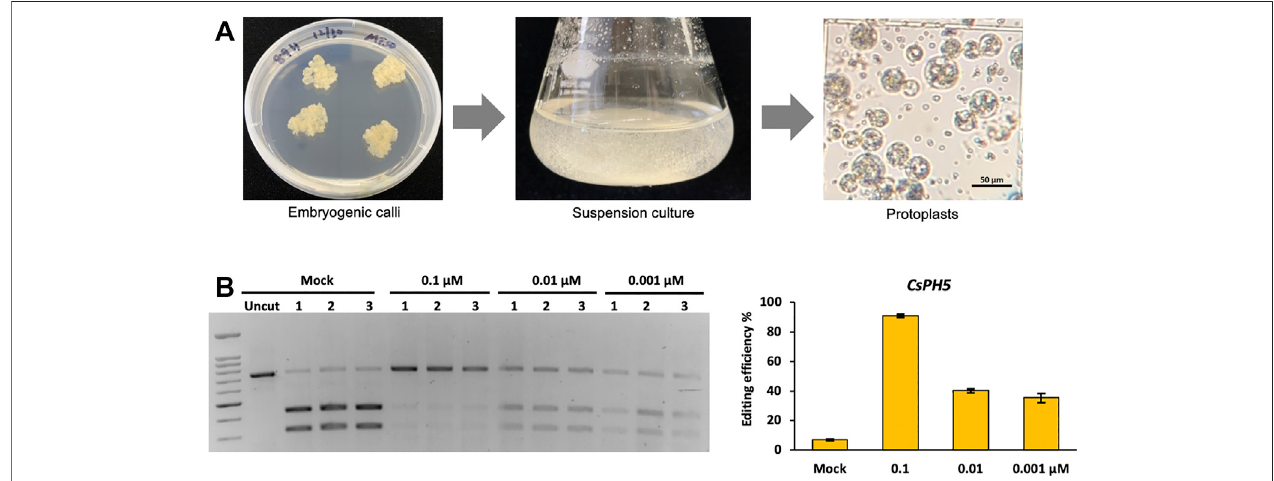
FIGURE7| LbCas12agenomeeditingincitruscellswithRNPdelivery. (A) Apipelineforproduction ofprotoplasts fromanembryogenicsweetorangeline,Hamlin 89. (B) Editing ef fi ciencies of LbCas12a are calculated using the RFLP assay with three RNP concentrations, 0.1, 0.01, and 0.001 μ M at gene CsPH5 at 28 ° C. The left panelshowstheRFLPassay,andtherightpanelshowsthequali fi cationofmutationfrequenciesbasedontheRFLPassay.Dataarepresentedasmeanvalues±SEMof three biologically independent replicates.